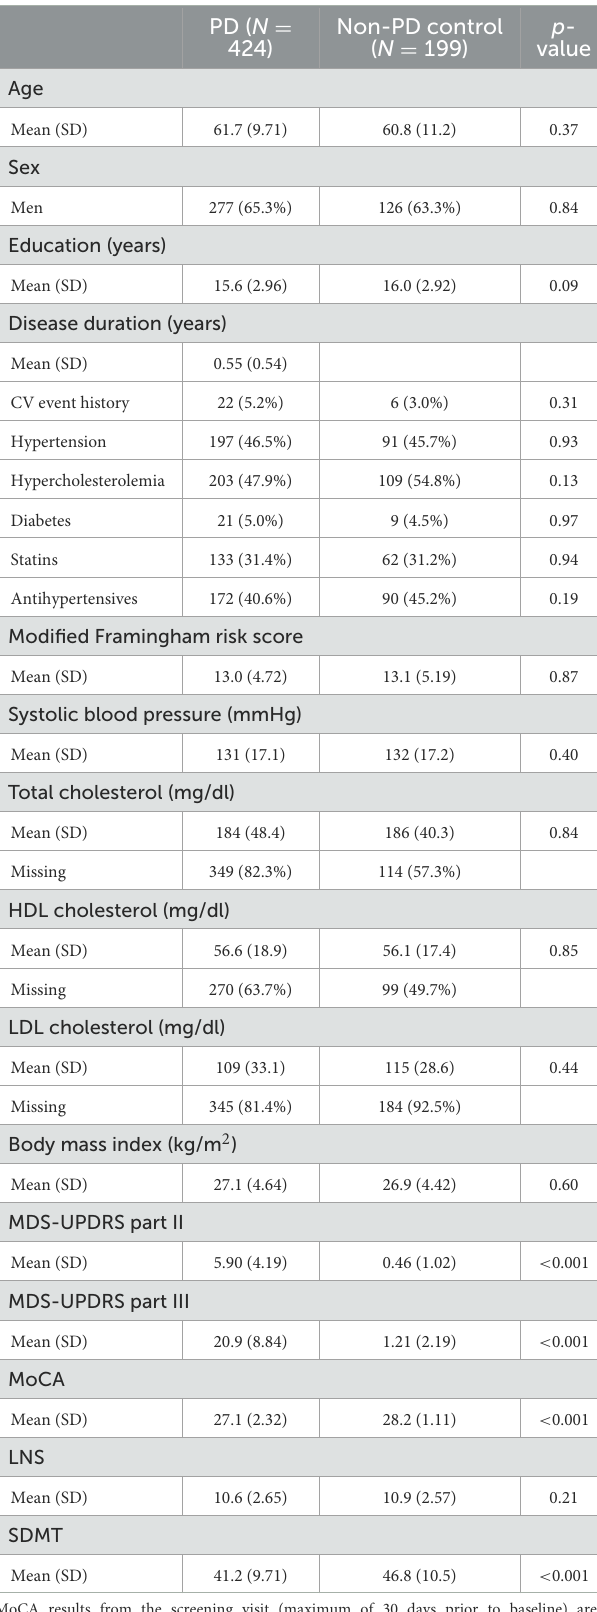
TABLE 1 Demographics, disease characteristics and cardiovascular risk factors at baseline of individuals included in the PPMI